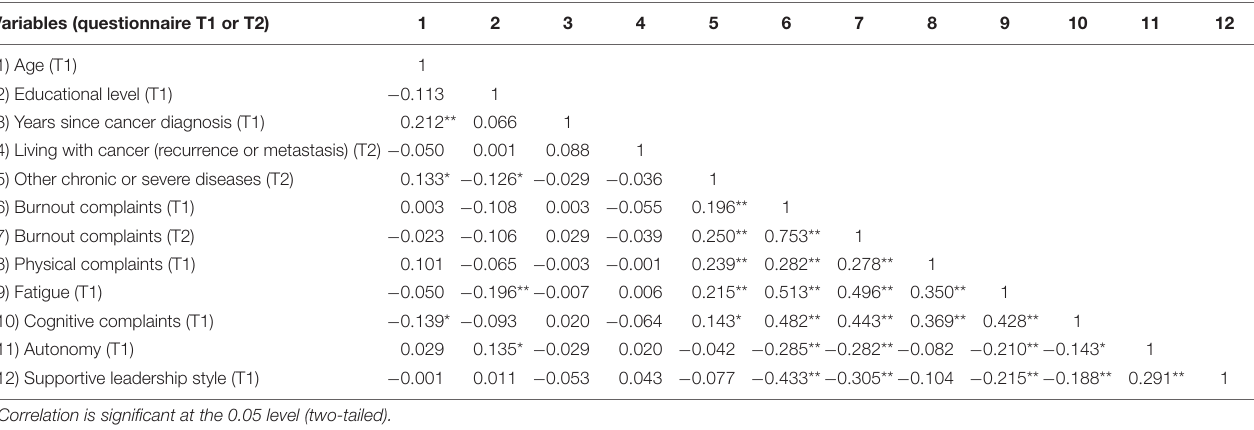
TABLE 2 | Correlations of demographics (age, educational level), control variables [years since cancer diagnosis, living with cancer (recurrence or metastasis), other chronic or severe diseases, burnout complaints at T1], dependent variable (burnout complaints at T2), independent variables (physical complaints, fatigue, and cognitive complaints at T1), and possible moderators (autonomy or supportive leadership style at T1) ( N = 278).